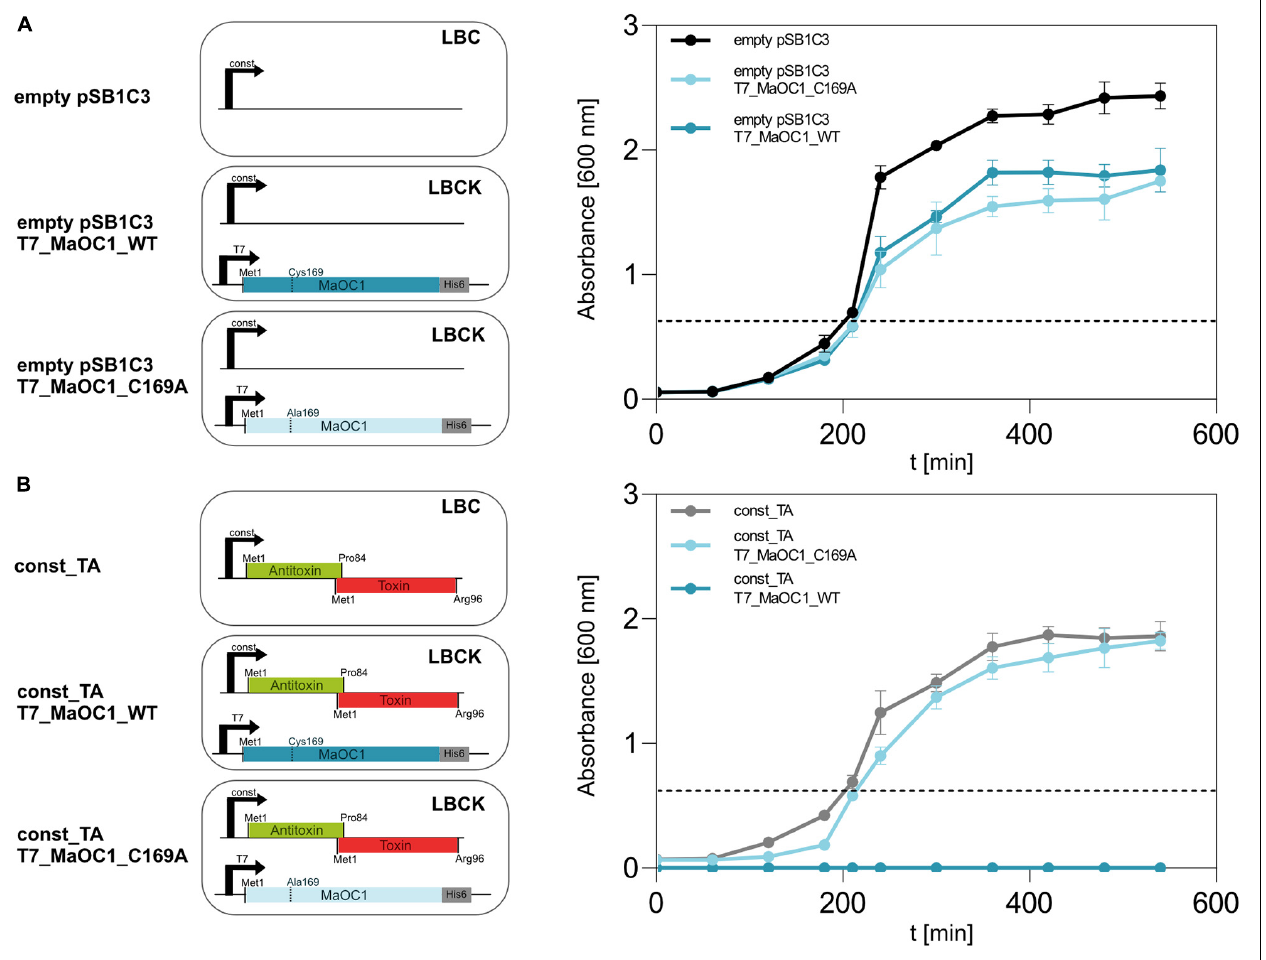
FIGURE 7 | Growth of BL21(DE3) E. coli cells expressing TA operon or/and MaOC1 under constitutive and inducible conditions. BL21DE3 E. coli cells were transformed either with a pSB1C3_empty (A) or a pSB1C3_toxin_antitoxin (B) plasmid. Those cells were further used for co-transformation with pET28_MaOC1_WT/C169A plasmid (T7_MaOC1_WT or T7_MaOC1_C169A). The cells containing the respective plasmids were cultured in liquid LB media supplemented with appropriate antibiotics (C, chloramphenicol; K, kanamycin; or both). Overnight cultures diluted to an initial OD 600 of about 0.05 (except for